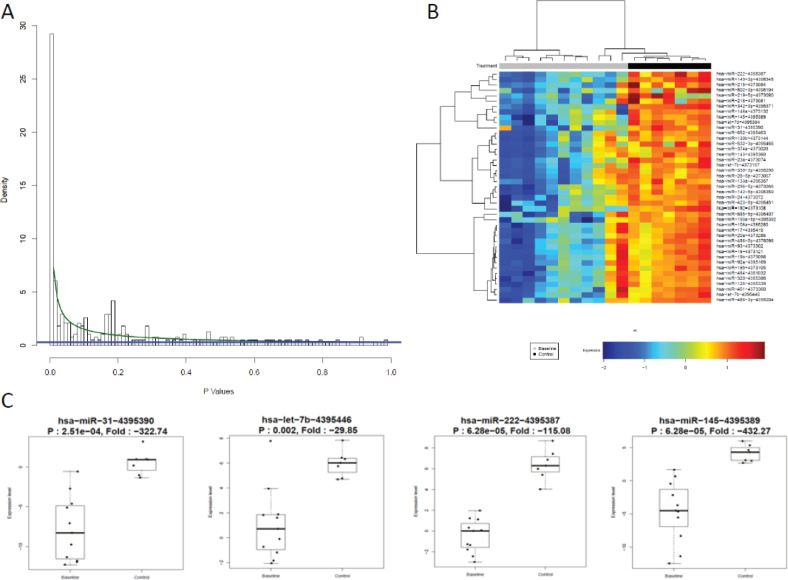
miR expression differs between controls and patients at baseline. (a): BUM analysis showed that a great number of miR were differentially expressed between patients and HV. At an FDR of 5%, 169 miRs were found to be relevant, p cutoff of 0.065. (b): Heat map of top differentially expressed miRs by two-way hierarchical clustering (miRs correlation by Pearson). Cancer patients underexpressed several miRs compared to HV. (c): Top miRs which were underexpressed in patients compared to volunteers are TS miRs.